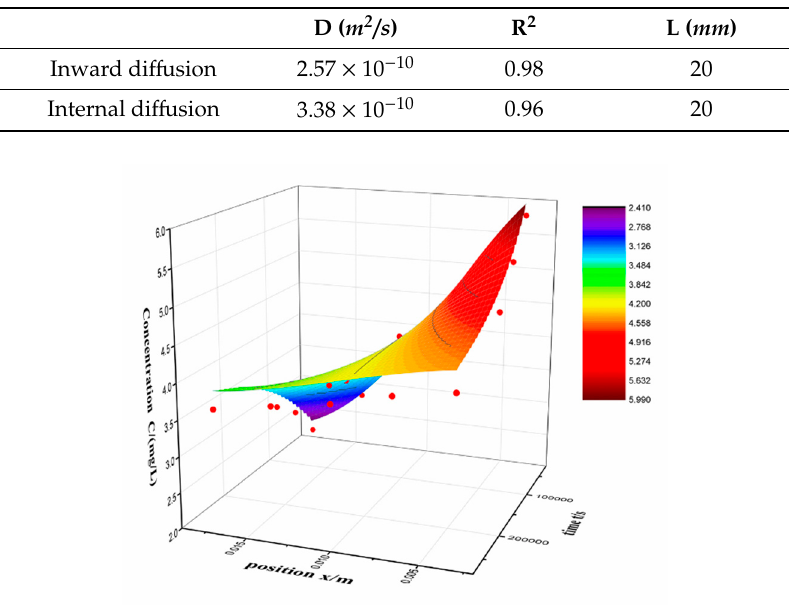
Figure 7. Original experimental data and fitted surface of internal diffusion.